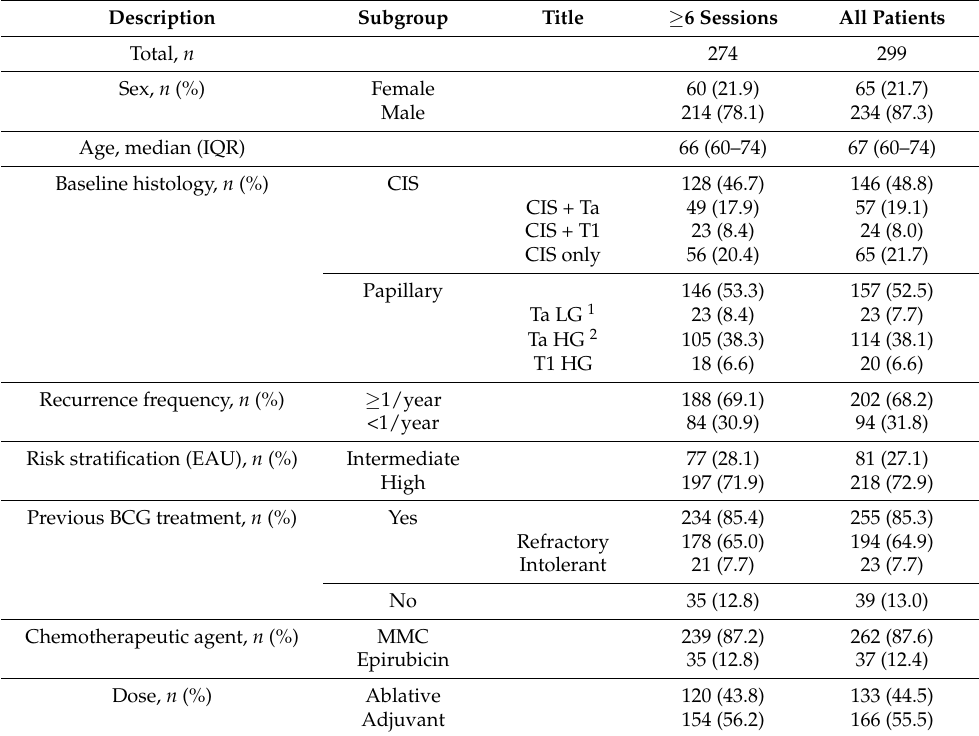
Table 1. Baseline characteristics of the study